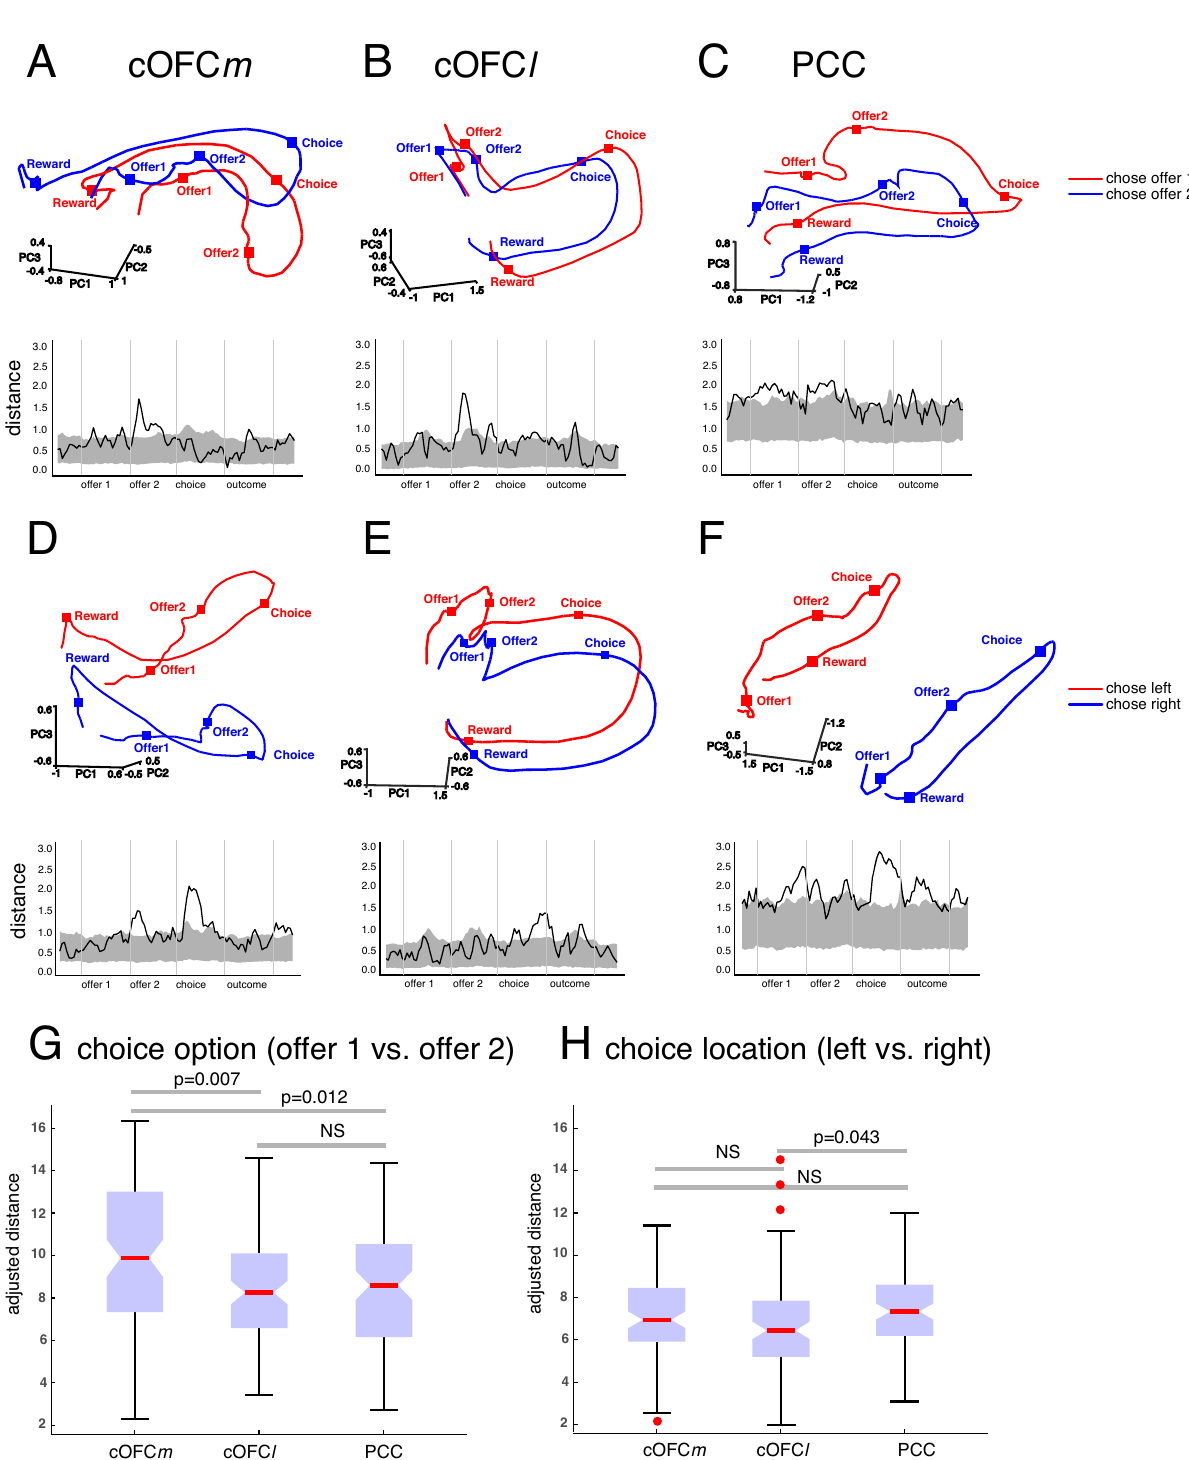
for chosen option and chosen location were also absent in error trials (Supplementary material), consistent with the intuitive idea that the areal difference in the unfolding trajectory separation contributes to correct choice behavior. Crucially, the separation between population trajectories for chosen option (offer 1 vs. 2) in cOFC m Granger-caused the separation between population trajectories for chosen location (left vs. right) in PCC (gc = 9.98, p = 0.019), with a 150 ms (6.67 Hz) lag. In the reverse direction, the distance between NATURE COMMUNICATIONS| (2022) 13:3623